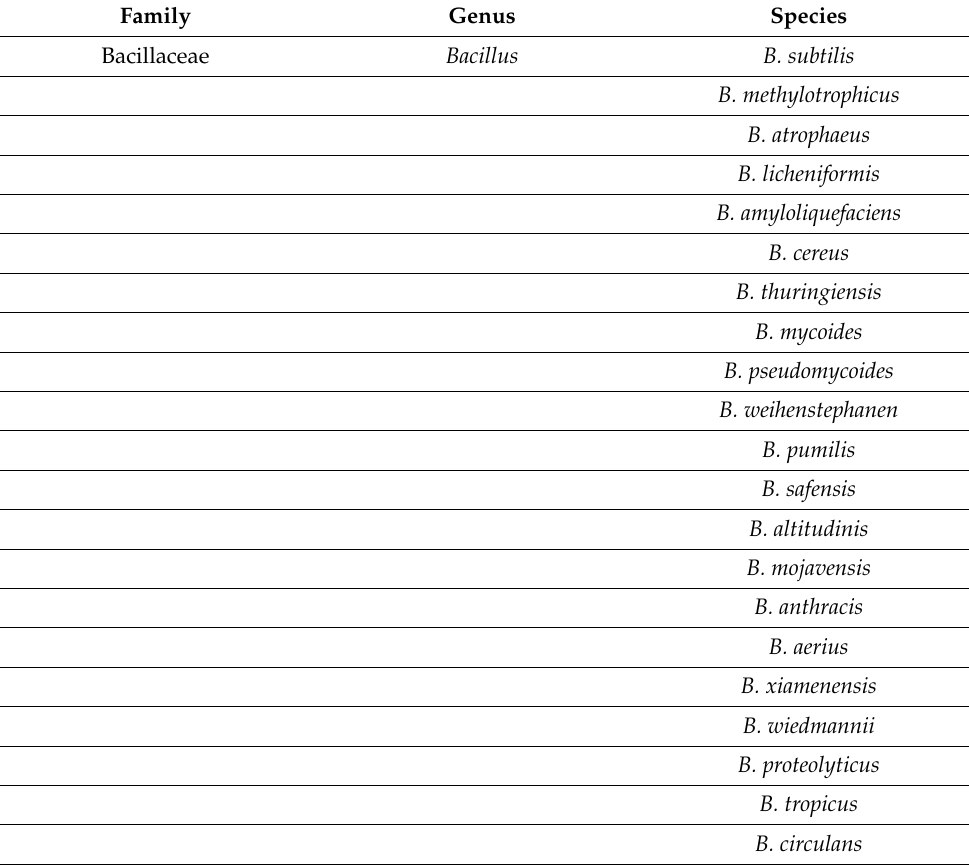
Table 3. Composition of the family Bacillaceae in honey identified by genotyping.